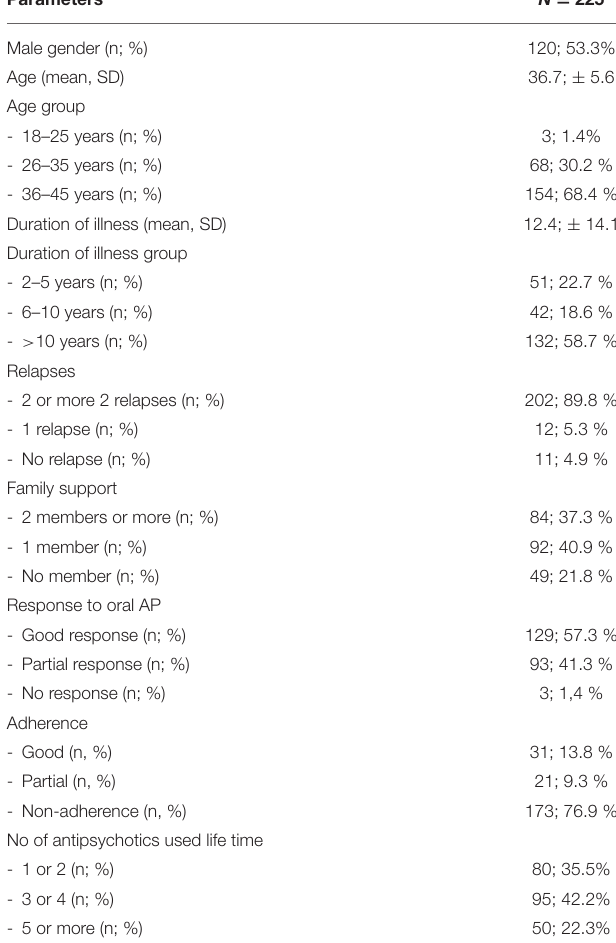
TABLE 2 | Patients